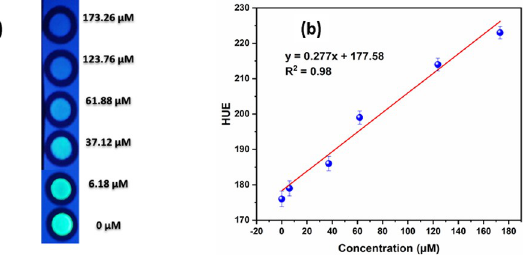
Fig 5. (a) Color changes of PSTs captured by smartphone (b) Relationship between hue values extracted from Color Picker App and spermine concentrations.